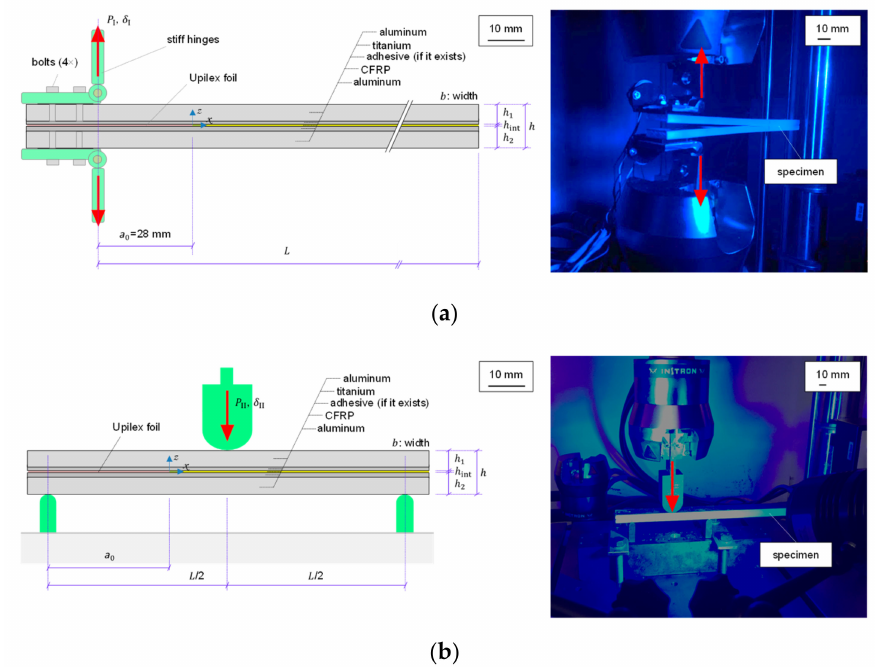
Figure 3. A schematic representation (in scale) of the experimental setup and a typical photograph during the experiment for the double cantilever beam (DCB) ( a ) and the end-notched flexure (ENF) ( b ) experiments (photographs are reproduced from [19], with permission from Elsevier,